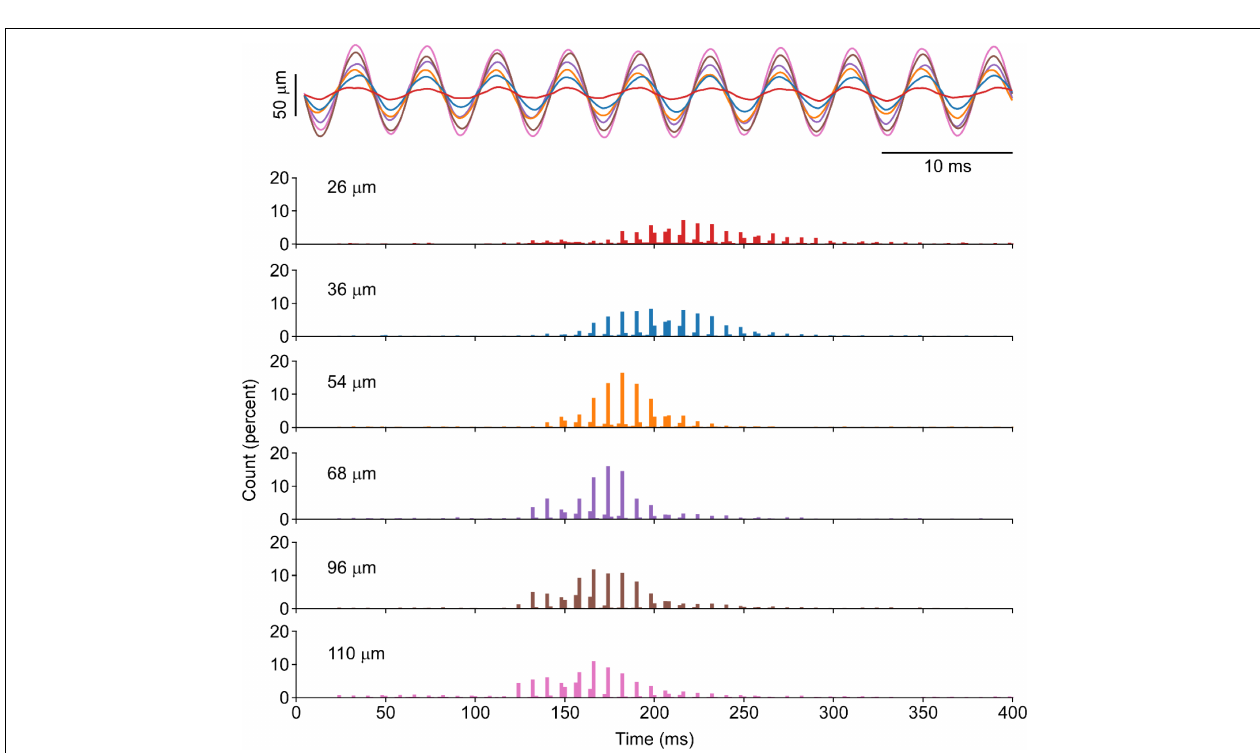
FIGURE 2 | Quantification of punctuated discharge in response to tendon vibration. The data from Figure 1 is used to demonstrate both analyses of punctuated discharge. (A) First, the mean subtracted, normalized cISI histogram is compared to a normative dataset of self-sustained discharge. The Euclidian distance is calculated between these histograms. (B) The distance between the TVR evoked cISI histogram is greater than the distance between cISI histograms derived from the self-sustained discharge. (C) Second, the absolute sum of the first derivative of the cISI histogram (ASD) during vibration is much greater than the ASD values found during self-sustained discharge. Both the distance and ASD measures suggest the TVR cISI histogram is more punctuated than the cISI histogram derived from a control dataset of self-sustained motor unit discharge.